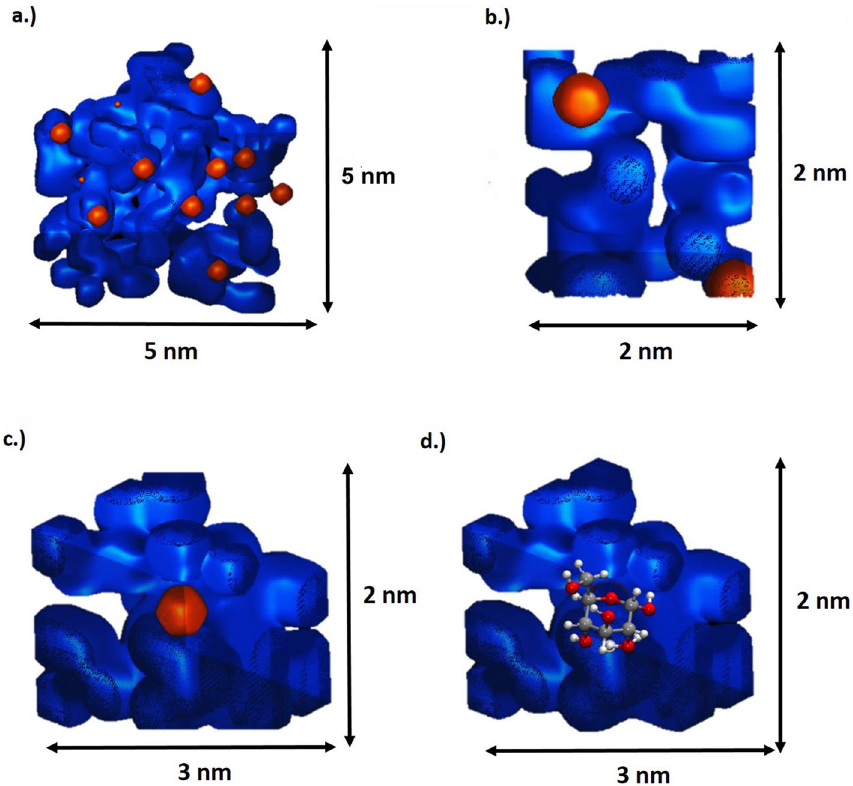
Figure 10. ( a – c ) Isosurfaces of water in blue 67% and the complete glucose molecule at m/z = 181 u in orange are shown to visualize the hydrate shell of the solvent glucose molecules. ( d ) DFT calculated molecule structure inserted at the determined glucose molecule